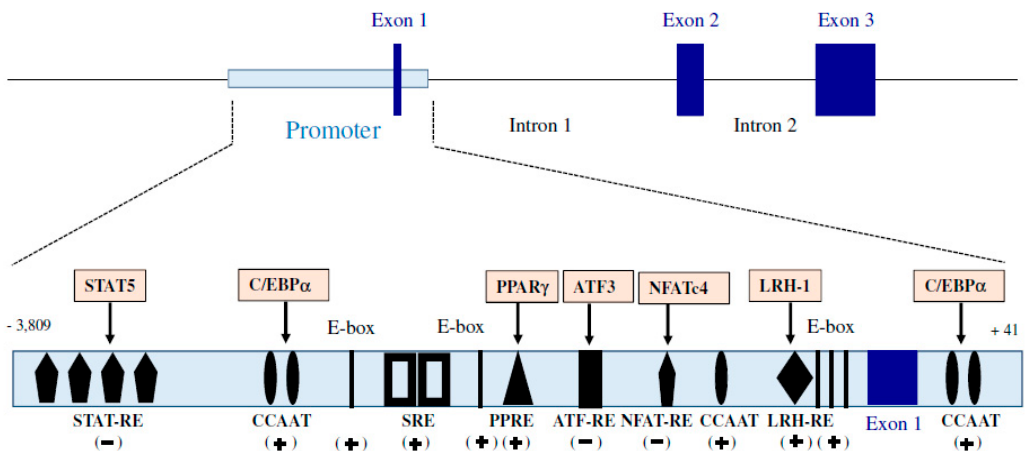
Figure 1. Structure of adiponectin gene and its promoter region. Binding sites (cis-elements) are STAT-RE: Signal Transducers and Activators of Transcription Response Element; CCAAT: CCAAT box is a distinct pattern of nucleotides with GGCCAATCT consensus sequence; SRE: Serum Response Element; PPRE: Peroxisome Proliferator Response Element; ATF-RE: Activating Transcription Factor-Response Element; LRH-RE: Liver Receptor Homolog 1 Response Element; E-box: Enhancer-box; NFAT-RE: Nuclear Factor of Activated T cells Response Element. Transcription factors (trans-elements) are STAT5: Signal transducer and activator of transcription 5; C.EBP α : CCAAT/enhancer-binding protein alpha; PPAR: Peroxisome Proliferator-activated Receptor gamma; ATF3: Activating Transcription Factor 3; NFATc4: Nuclear Factor of Activated T cells 4; LRH-1: Liver Receptor Homolog-1. The stimulatory (+) and inhibitory ( − ) roles of each transcription factor in the adiponectin gene expression are shown below the binding